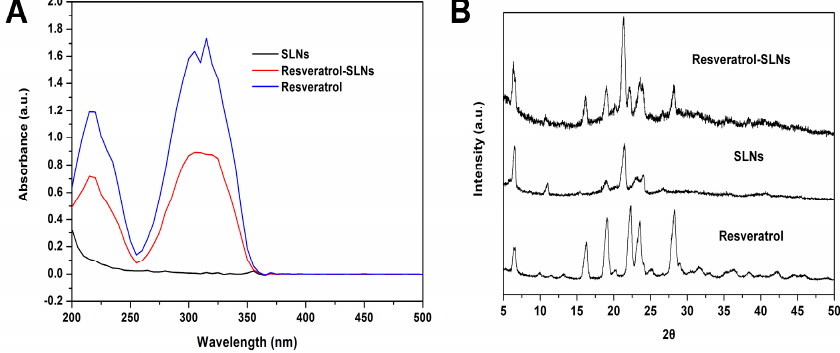
Figure 3. ( A ) UV–vis curves of Resveratrol, SLNs, Resveratrol-SLNs; ( B ) X-ray diffraction curves of Resveratrol and Resveratrol-SLNs.